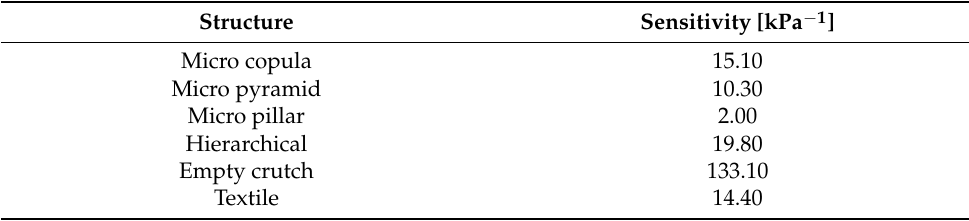
Table 4. Chosen piezoresistive sensor designs [52,62–67].